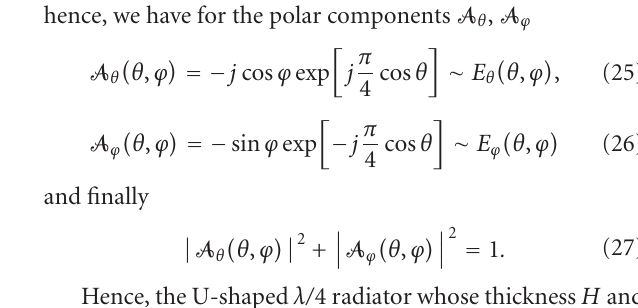
Hence, the U-shaped λ/ 4 radiator whose thickness H and width W tend to zero radiates its power isotropically in the